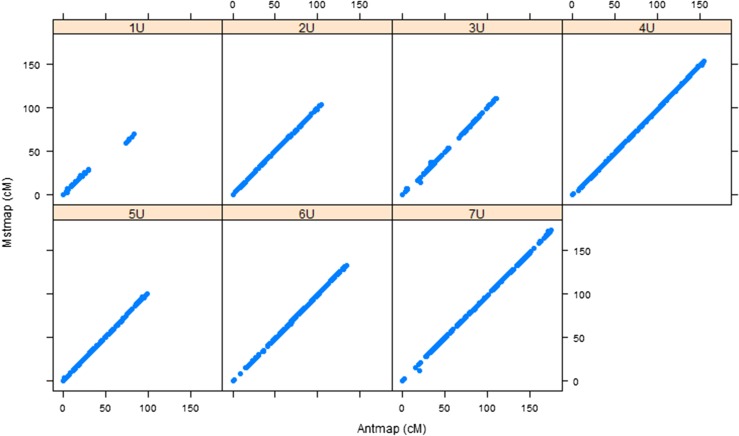
Comparison of linkage maps constructed with MSTMap and Antmap algorithms for Aeupop1. The x-axis indicates the genetic distance centimeter based on Antmap software, whereas the y-axis indicates the genetic distance centimeter based on MSTMap software for each chromosome.